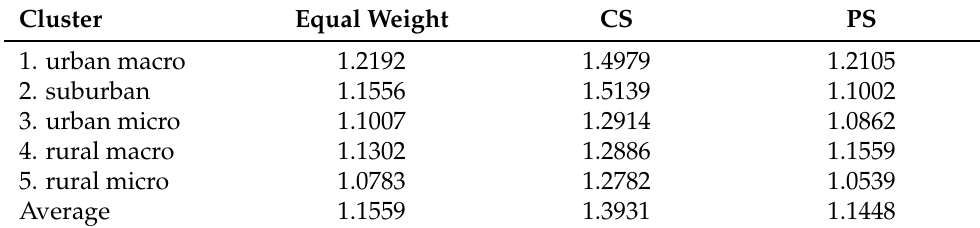
Table 6. Composite indicator per cluster and